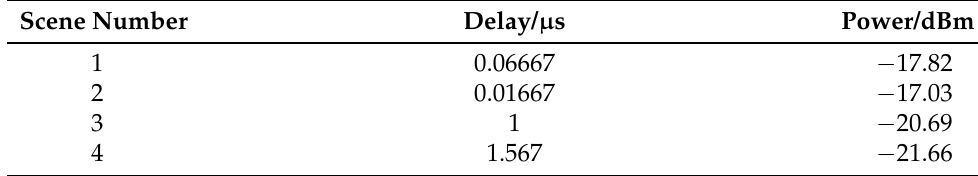
Table 2. Comparison for four